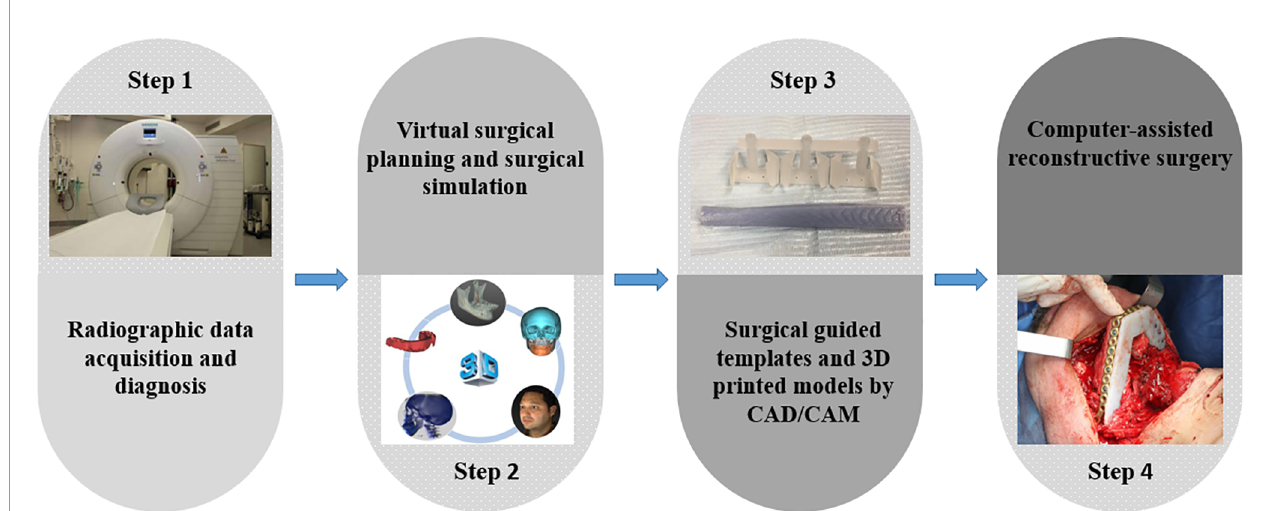
FIGURE 1 | Work fl ow of Computer-assisted surgery in our single